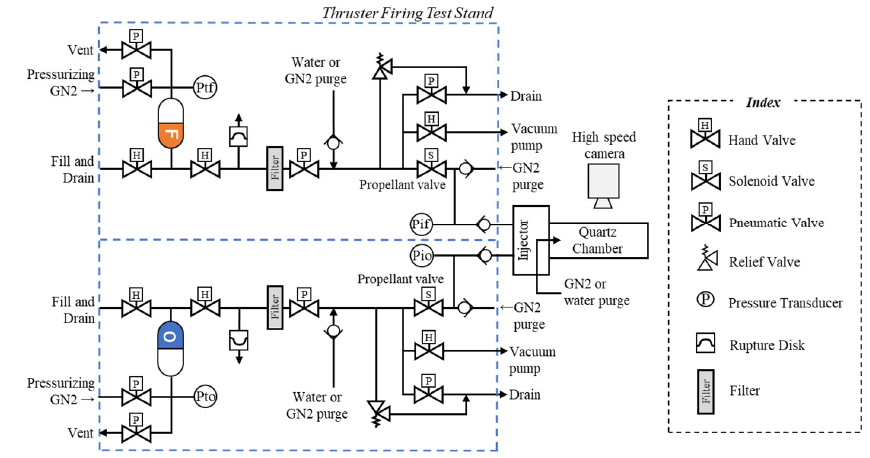
Figure 11. Schematic diagram of impinging ‐ jet test system.